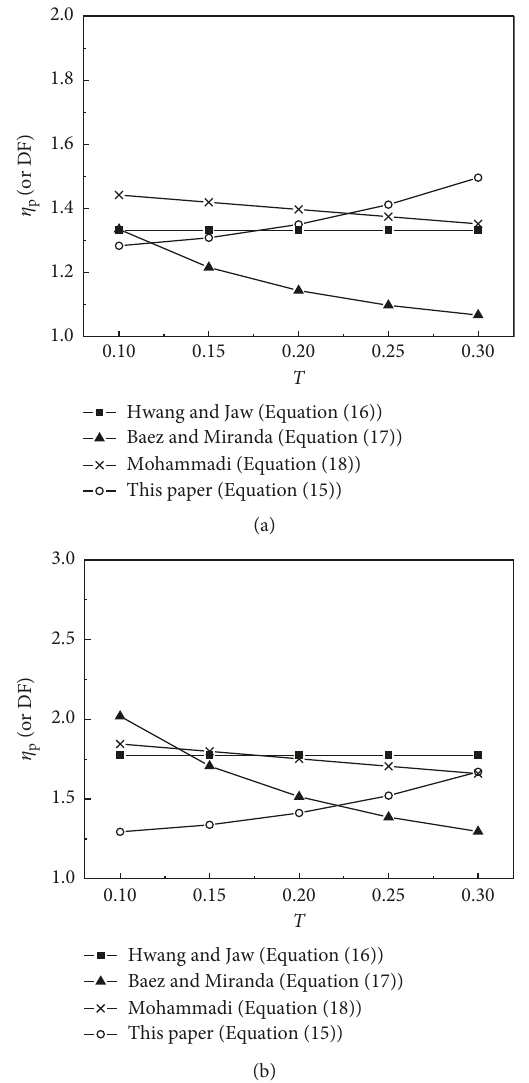
Figure 19: Comparison between different suggested values of deflection amplification factor for 3-storey model ( T � 0.02 ∼ 0.03) H : (a) μ � 2.0 and (b) μ �